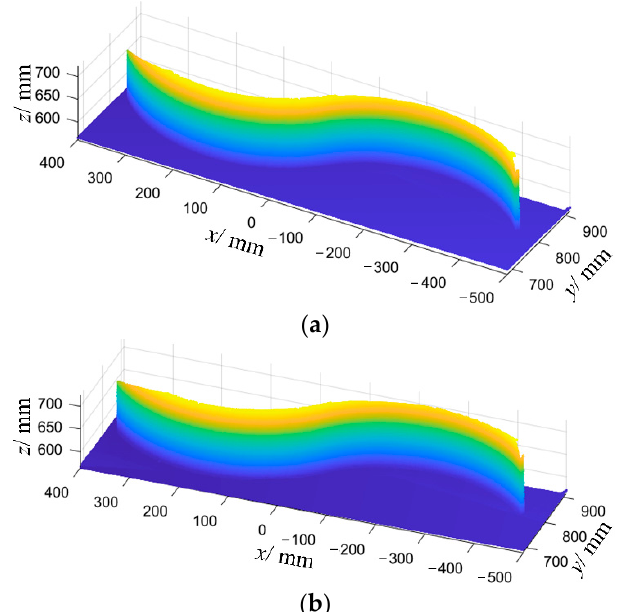
Figure 16. The point cloud data of the weldment under the welding sequence " ①②③④⑤⑥ ": ( a ) before welding; ( b ) after welding.